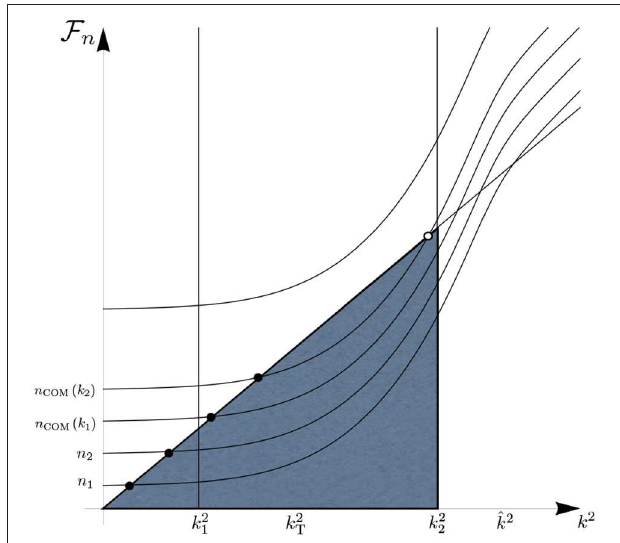
FIGURE 2 | Schematic sketch of a non-trivial spectral